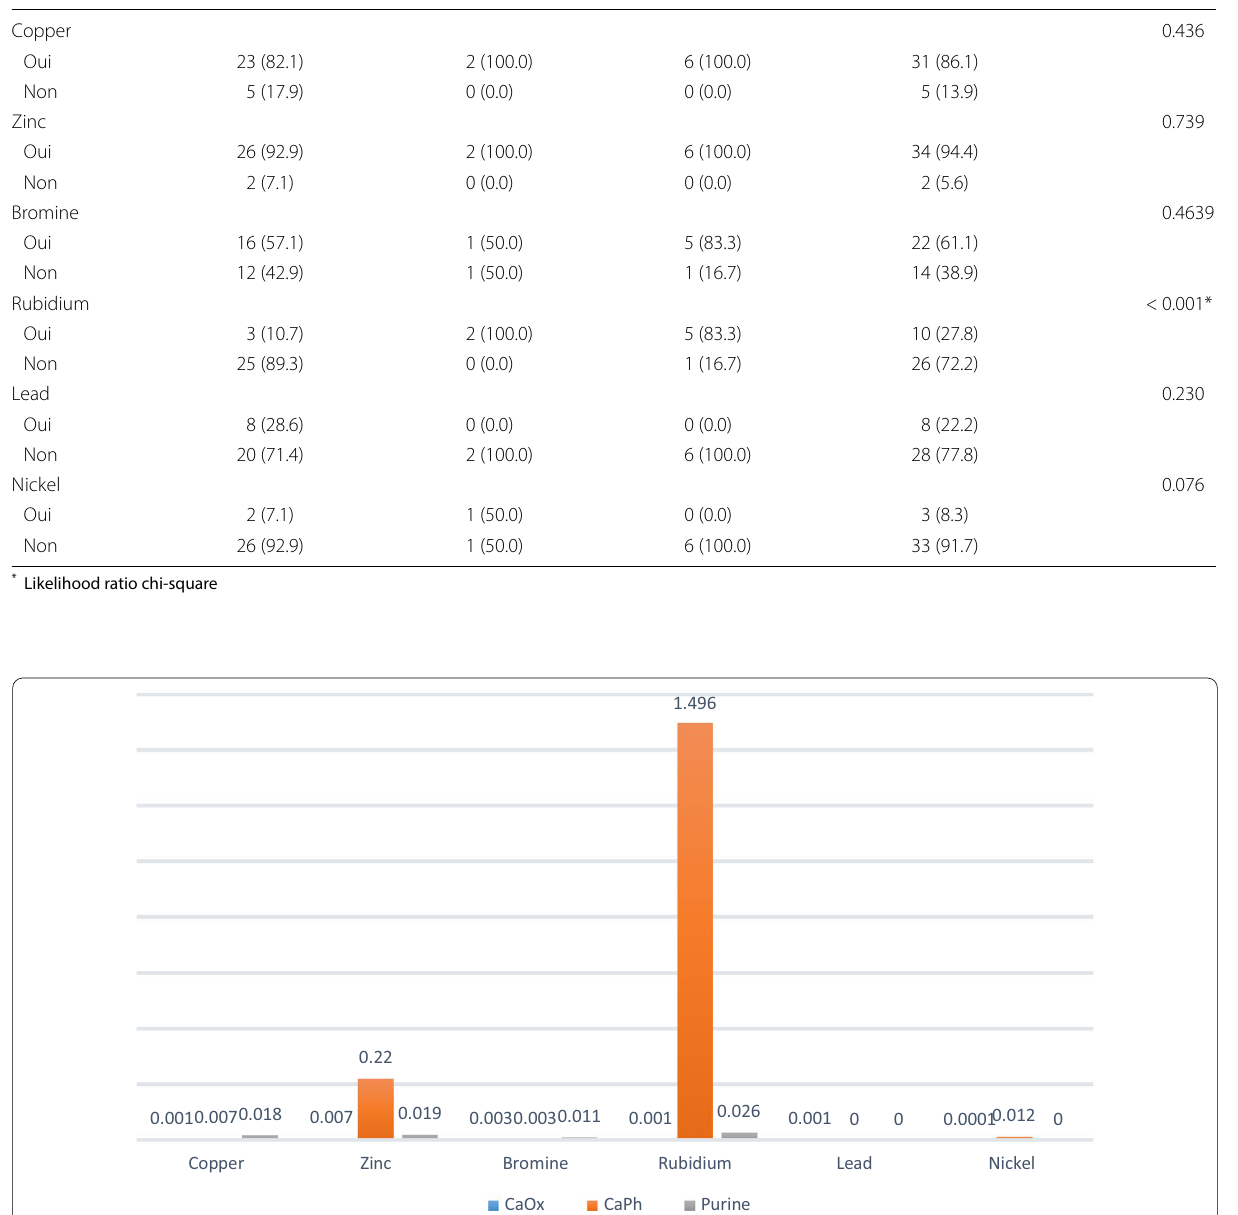
Fig. 4 Average metal / calcium according to the main components of stones grouped